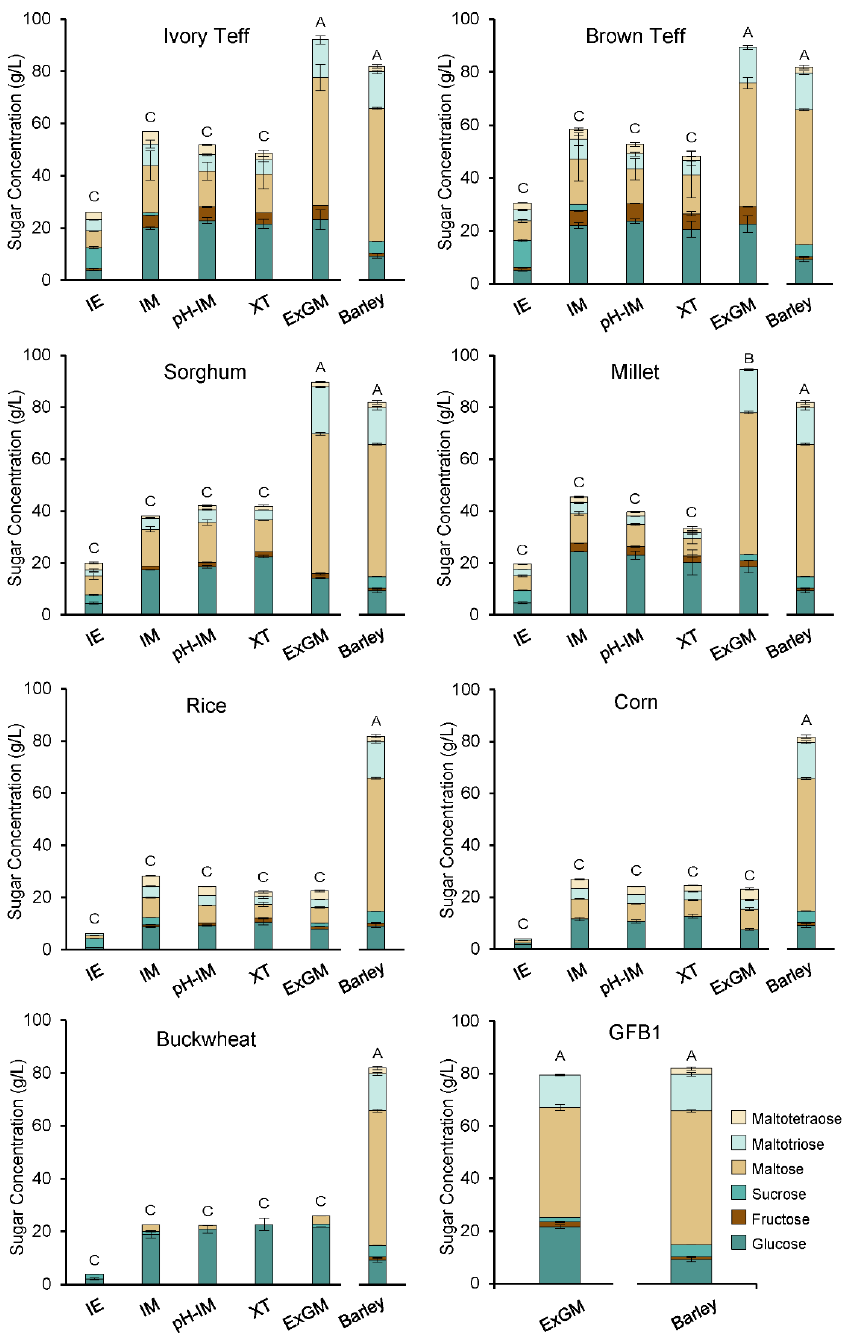
Figure 4. The effect of mashing treatment on the generation of glucose, fructose, sucrose, maltose, maltotriose, and maltotetraose in GF malts as compared to barley mashed using the IM procedure. One-way ANOVA on total fermentable sugars with Dunnett’s post-toc test ( α = 0.05) was used to determine significant differences in total fermentable sugars from the barley control. The mashing treatments outlined in Table 1 are: inactivated enzymes (IE), infusion mash (IM) pH-adjusted infusion mash (pH-IM), extended time infusion mash (XT), and the ExGM decoction (ExGM). The ExGM decoction maintains enzyme activity via mashing at a low temperature, but separates the enzyme from the starch allowing for gelatinization without enzyme denaturation. Samples labelled with letters differing from the barley control are significantly different. Data represent the means ( n = 2) ± standard deviations, and some error bars overlap or are within series borders.